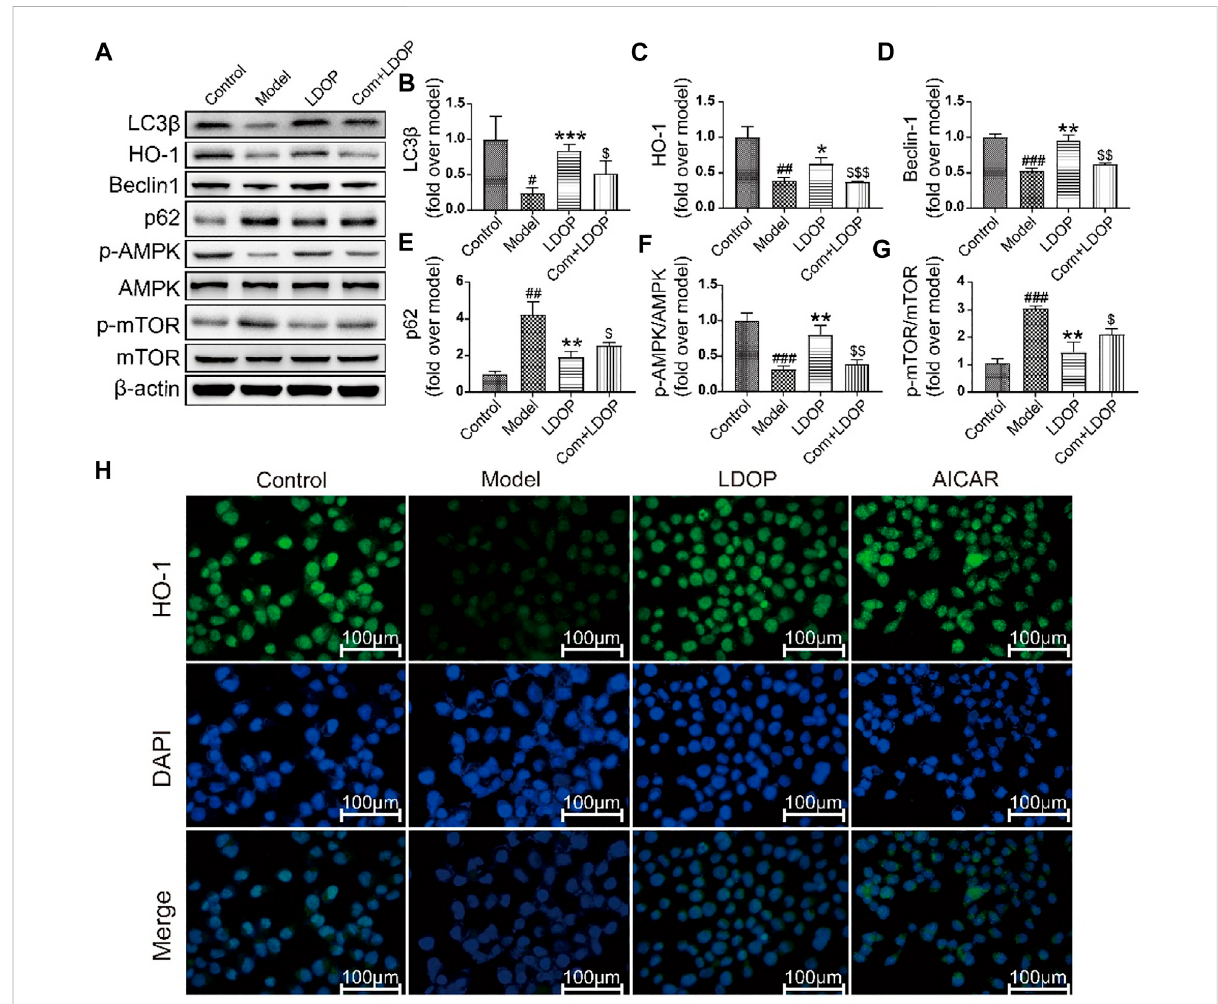
FIGURE 10 LDOPcouldactivatetheautophagybymTOR/AMPKsignalingway invitro . (A) TheexpressionofLC3 β ,HO-1,Becline-1,p-AMPK,p62,p-mTOR detected by Western blot. (B – G) Statistical analysis on LC3 β , HO-1, Becline-1, p-AMPK, p62, p-mTOR. Immunohistochemical image of HO-1 (H) measured by immuno fl uorescence technique. Data areexpressedas the mean ± SD ofthree independentexperiments. # p < 0.05, ## p < 0.01, ### p < 0.001 compare the control group; * p < 0.05 and ** p < 0.01, *** p < 0.001 compare model group, $ p < 0.05, $$ p < 0.01, $$$ p < 0.001 compared with LDOP